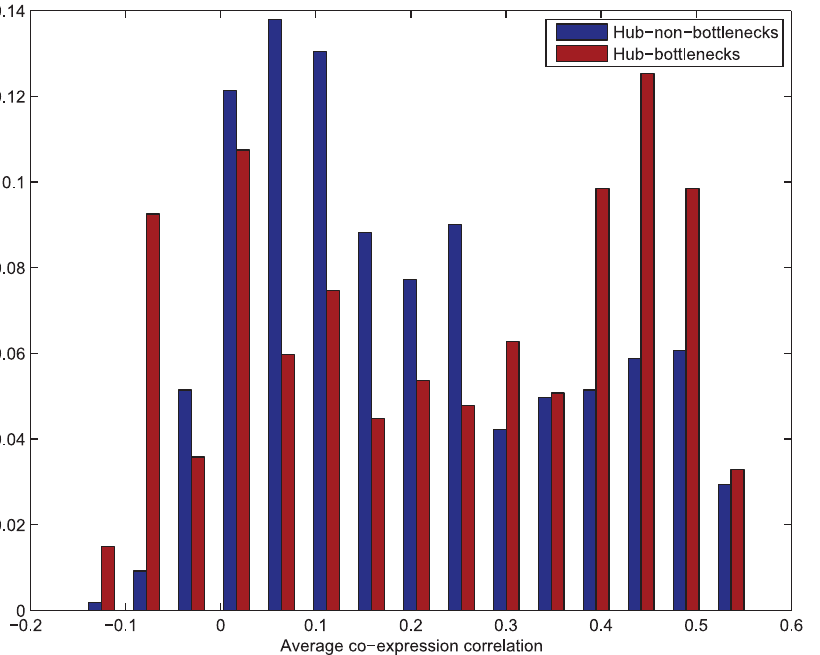
Figure 4. Expression Dynamics of Hub–Nonbottlenecks and Hub–Bottlenecks Histograms of the average correlation coefficient of the expression profile of any given gene with its direct interaction partners. Expression dynamics for all four categories of nodes are shown in Figure S7.